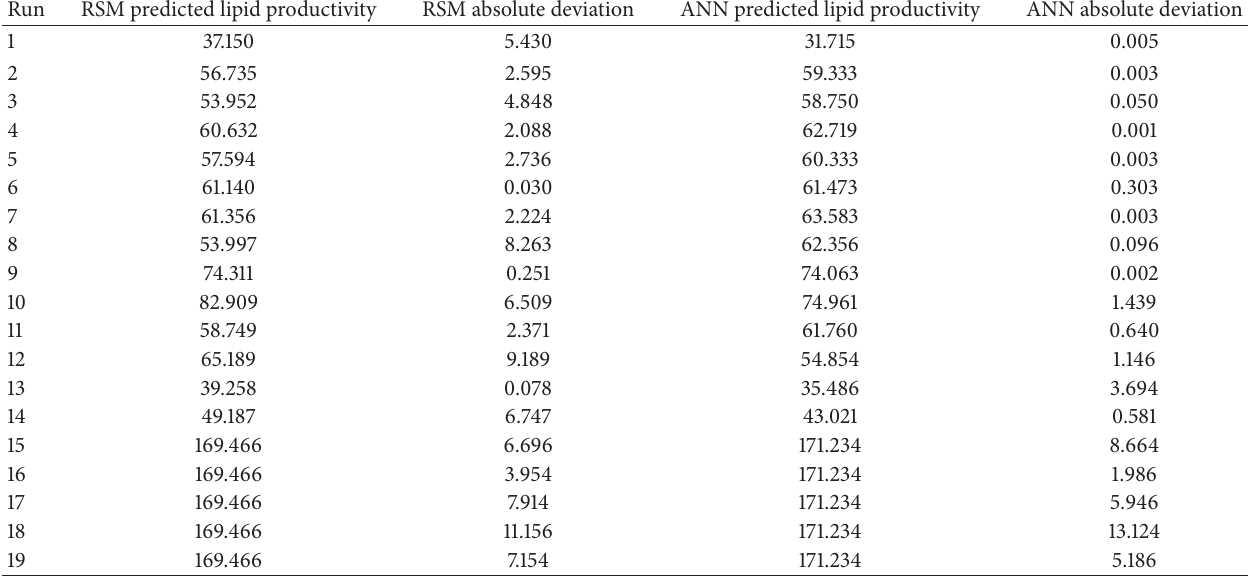
Table 5: Predicted lipid productivity by RSM and ANN together with the residual error functions ( 𝑅 2 , RMSE, and MAE).